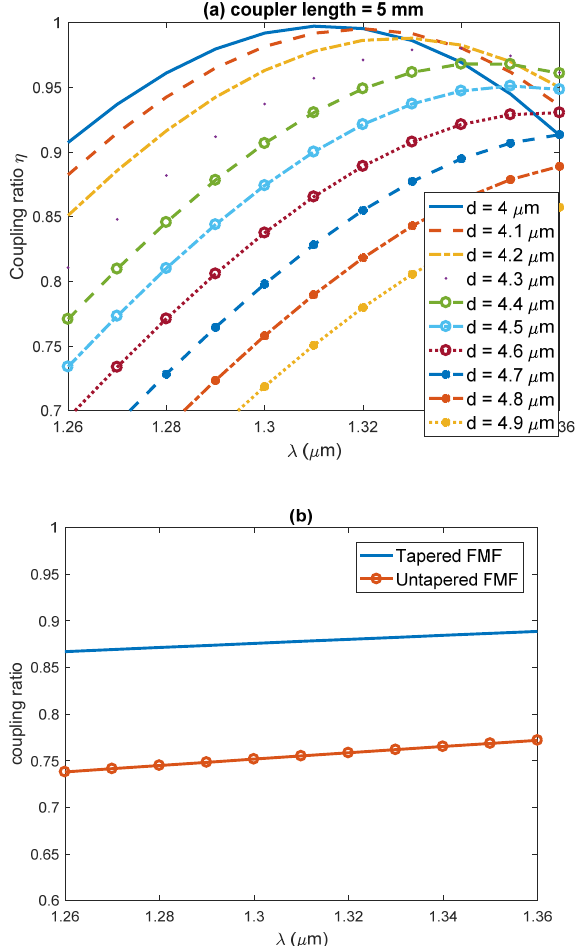
Figure 6. (a) Broadband coupling of the device with varying core ‐ to ‐ core separation d, from 4 to 4.9 μ m , and a fixed coupler length L of 5 mm. ( a ) coupler length = 5 mm; ( b ) Mode coupling of SMF LP 01 to FMF LP 01 mode in tapered FMF (solid line) and untapered FMF (solid line with circles) through direct fusion splicing.